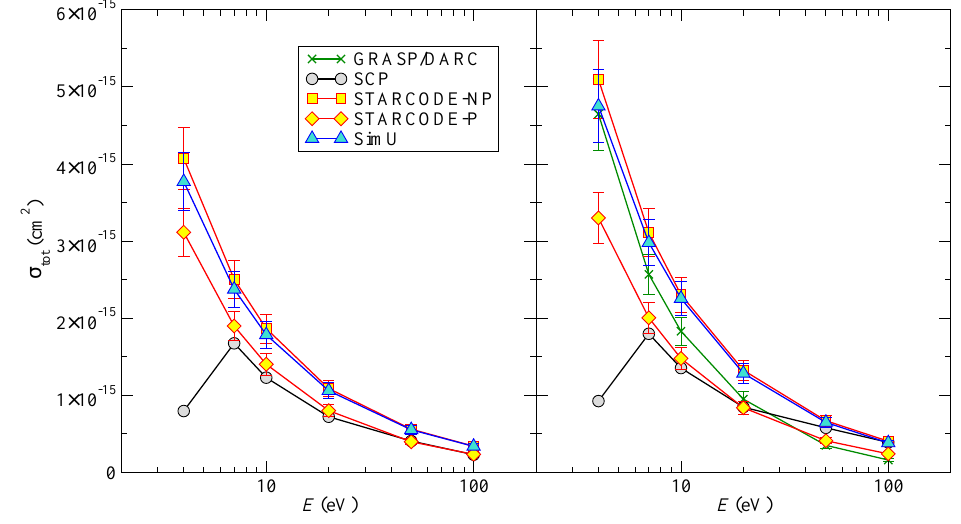
Figure 11. B III 2 s − 2 p total cross-section as a function of the energy E . ( Left ) only the dipole interaction is taken into account; ( Right ) the dipole and quadrupole interaction are both taken into